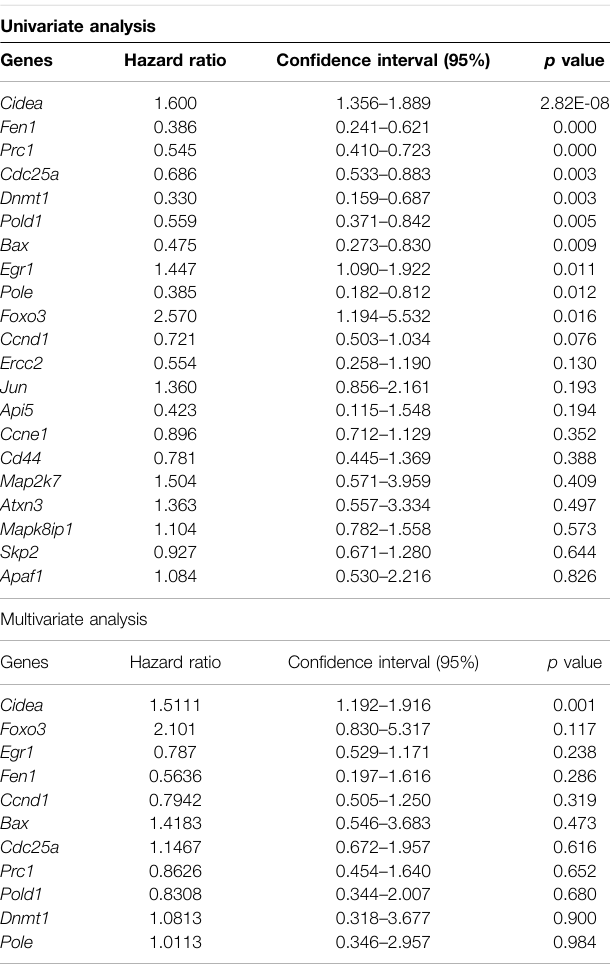
Biomarker comparison and validation of Survival gene expression data by ServExpress software. Dataset: BRCA-TCGAbreast-invasivecarcinoma. Hazard ratio was estimated by fi tting a CoxPH using risk group as covariate. LPD, group with maternal low-protein diet and N -methyl- N -nitrosourea administered as a single intraperitoneal dose of 25 mg/kg at postnatal